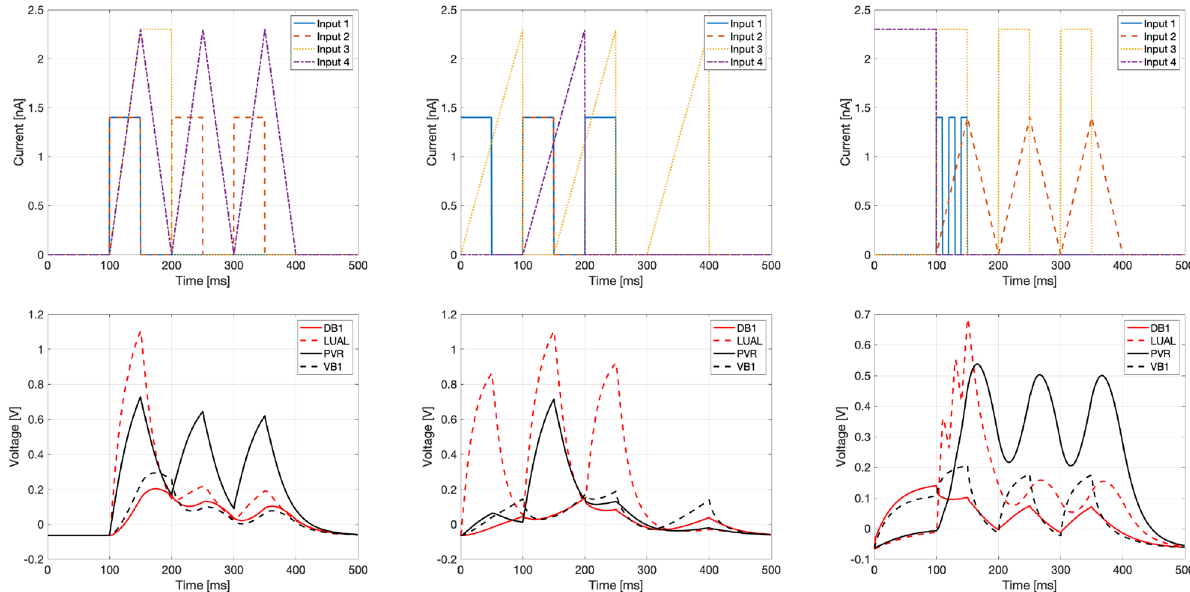
Figure 4. Example input (top row) and output (bottom row) time